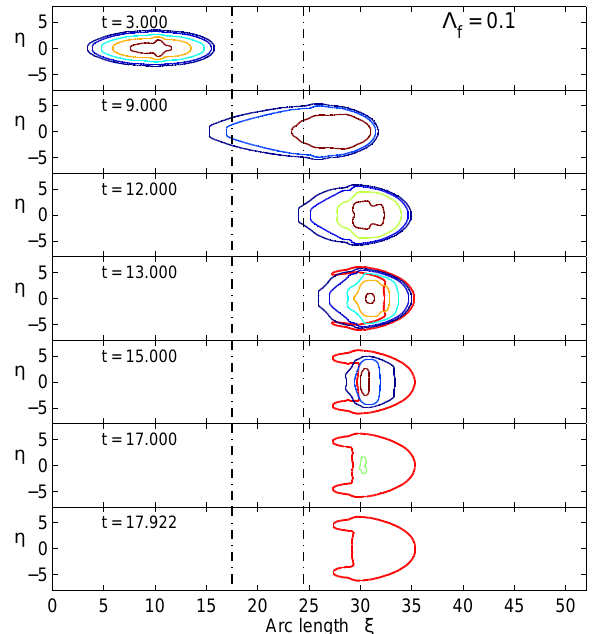
Fig. 4. Contour plots of the flowing mass and the evolution of the deposition heap, where Λ f = 0 . 1 with the deposition procedure be- ing adopted in the computation.